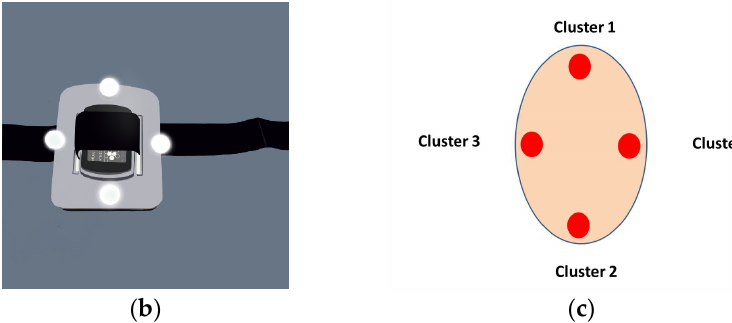
Figure 3. Images ( a , b ) are the rigid plates for IMU and CBM set of OMC ( c ). The cluster-based marker (CBM) set for an optical motion capture (OMC). Both the IMU and the cluster were built with the same coordinate